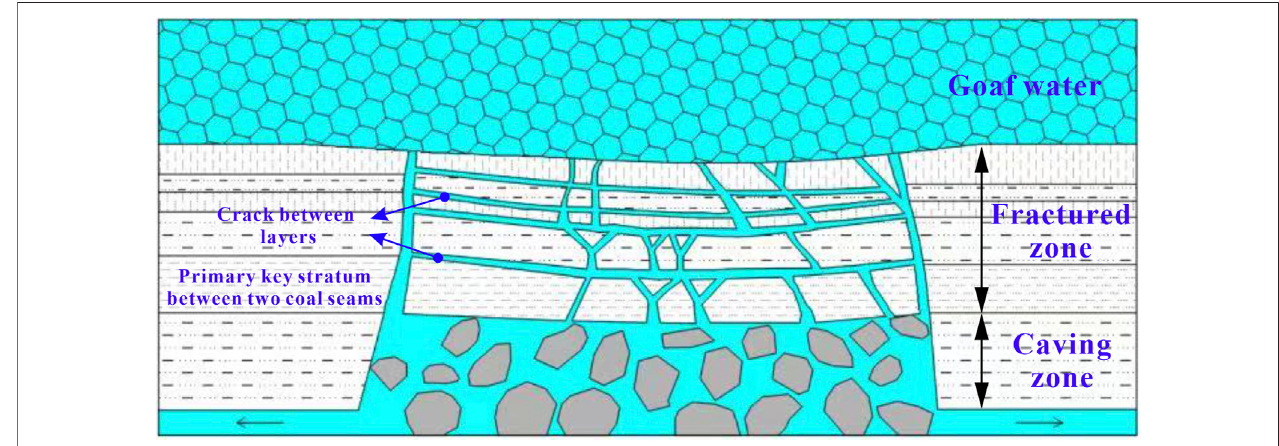
FIGURE 9 | Diagram of water inrush from the superjacent goaf of No. 18401